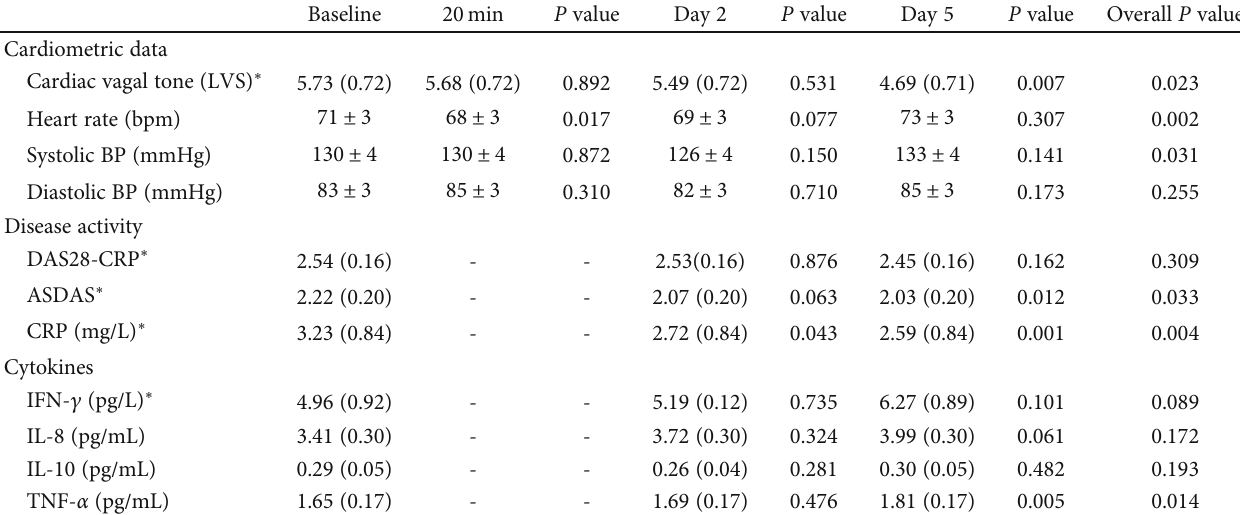
Table 2: Result — psoriatic